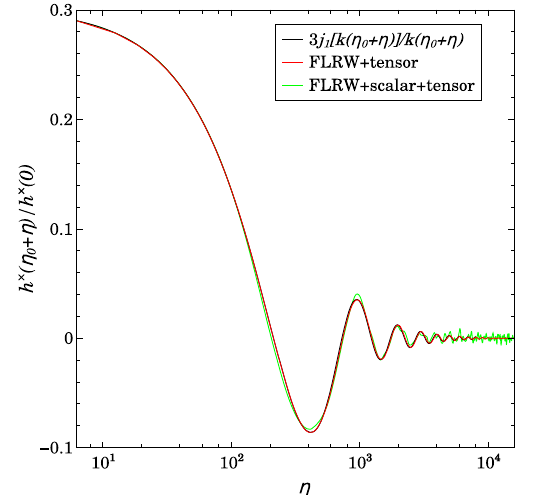
× (η 0 + η) Fig. 2 The evolution of h at the origin of our simulation box. h × ( 0 ) , where j 1 ( z ) = sin z − z cos z The black curve is drawn by 3 j 1 [ k (η 0 + η) ] k (η 0 + η) z 2 is the spherical Bessel functions of order one. The red curve is the in simulations with only tensor perturbations. The evolution of γ 12 (η) ( a S ) 2 in simulations with scalar and green curve is the evolution of γ 12 (η) ( a S ) 2 tensor perturbations. We can see that the black curve and the red one arealmostcoincideandthereareslightdeviationsbetweentheredcurve and the green one. That is to say, we can relate γ 12 (η) ( to the evolution a S ) 2 of tensor perturbation h × (η 0 + η) in our